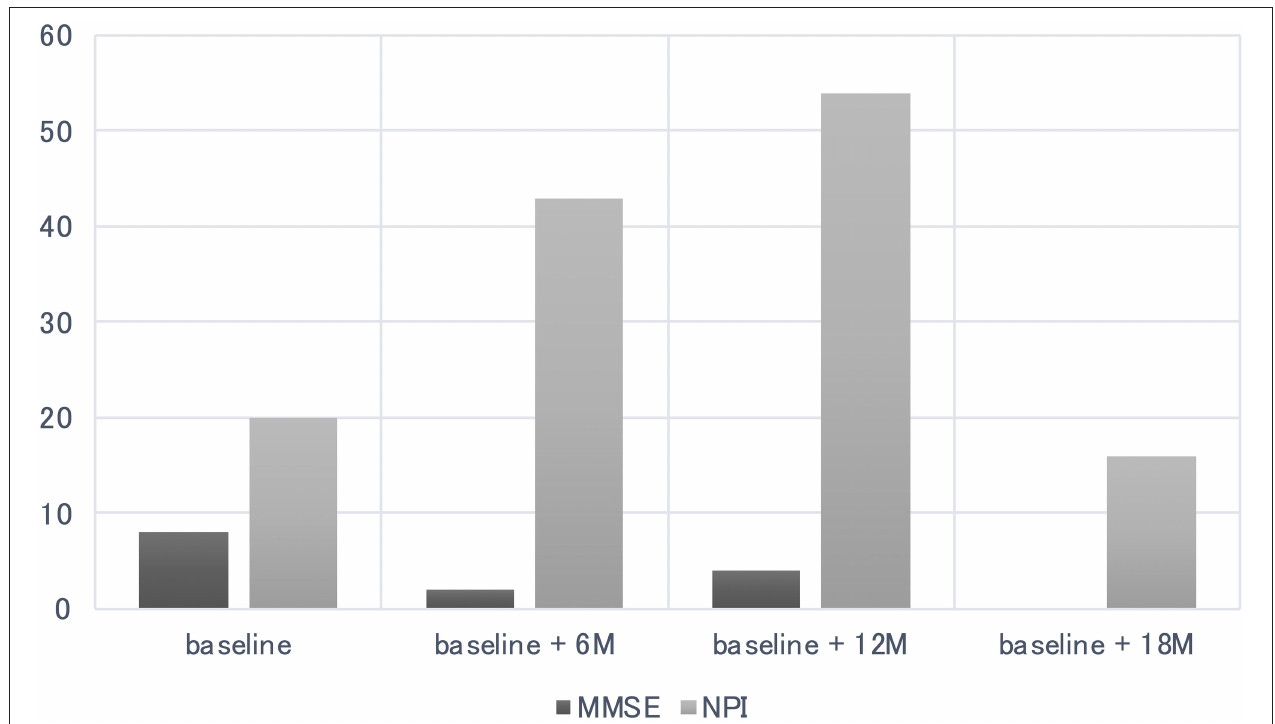
FIGURE 3 | Cognitive function of the participant declined further compared to pre-intervention, with a Mini-Mental State Examination (MMSE) scores of 4 after 1 year ( p = 0.388), behavioral and psychological symptoms of dementia (BPSD) peaked with the NPI score of 54 after 1 year ( p < 0.001). After a year and half, Ms. A’s MMSE score was 0 ( p < 0.001) and Neuropsychiatric Inventory (NPI) was 16 ( p = 0.617), but only apathy remained.